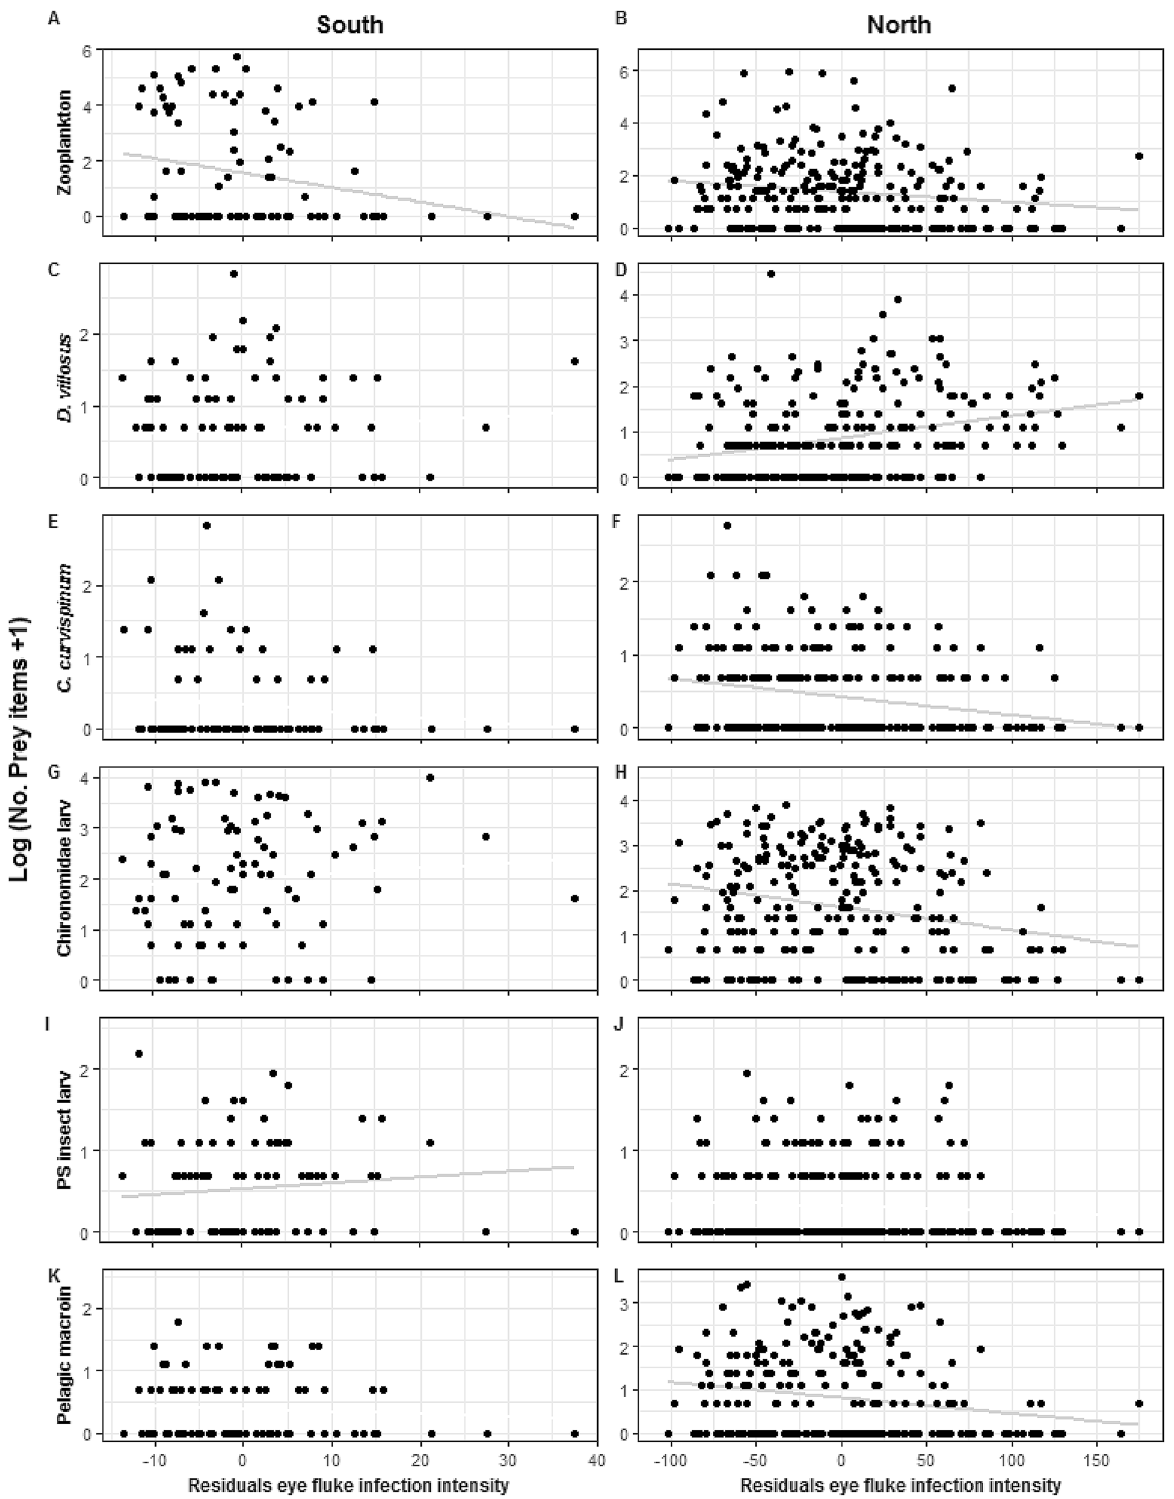
Figure 3. Eye fluke infection intensity corrected for fish size (residuals from the regression in Fig. 1) from perch ( Perca fluviatilis ) caught in two sampling sites of Lake Müggelsee in 2014 (left side: “South”, right side: “North”) and the number of consumed ( A , B ) zooplankton, ( C , D ) Dikerogammarus villosus , ( E , F ) Chelicorophium curvispinum , ( G , H ) Chironomidae larvae, ( I , J ) Predator-sensitive (PS) insect larvae and ( K , L ) pelagic macroinvertebrates. All prey data were log x + 1 transformed. Lines represent the best linear fit ((A) y = – 0.0052 x + 1.551; (B) y = – 0.0041 x + 1.363; (D) y = 0.0047 x + 0.864; (F) y = – 0.0024 x + 0.418; (H) y = – 0.0052 x + 1.628; (I) y = 0.0071 x + 0.524 (L) y = – 0.0037 x +